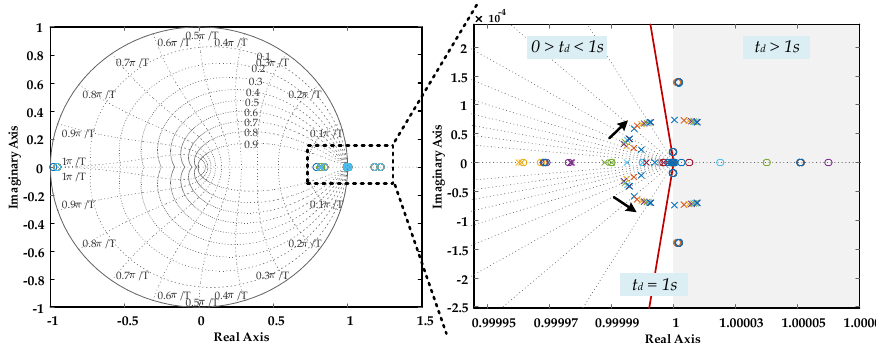
Figure 8. Effect of the time delay t d on system stability.